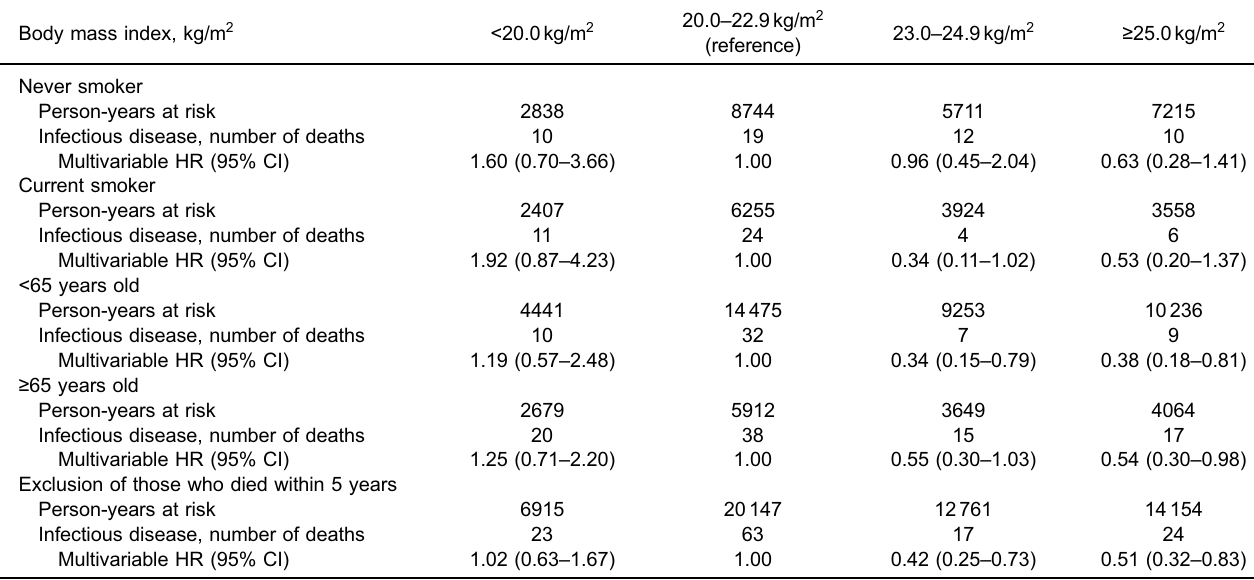
Table 3. Multivariable a hazard ratios for mortality from infectious disease according to body mass index, strati fi ed by smoking status, age, and exclusion of early